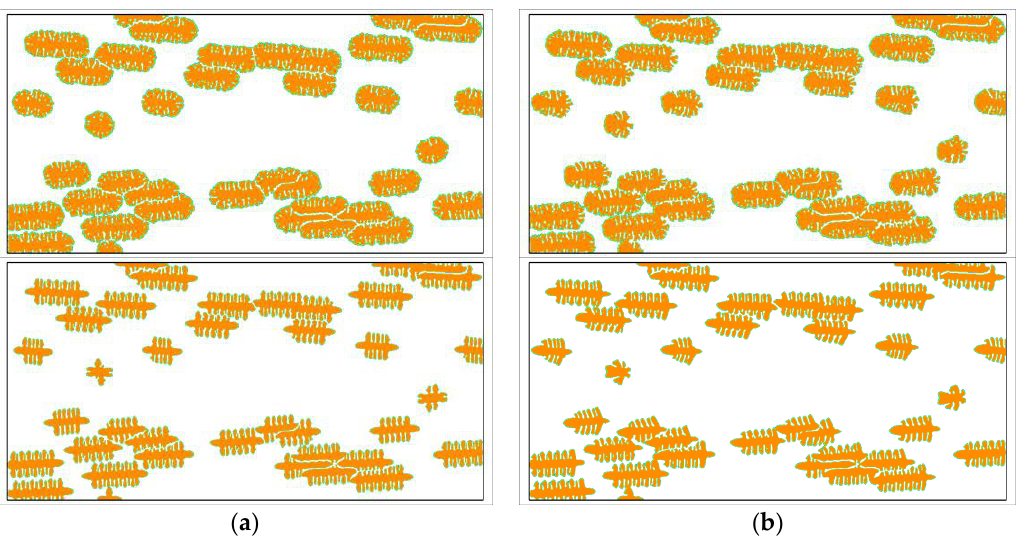
Figure 6. The comparisons between the simulated crystal morphology with and without fluid flow. The left and right columns are the results without and with flow, respectively. The results shown in the top row are triggered by noise and in the bottom row are triggered by the artificial anisotropy. ( a ) u 0 = 0; ( b ) u 0 =